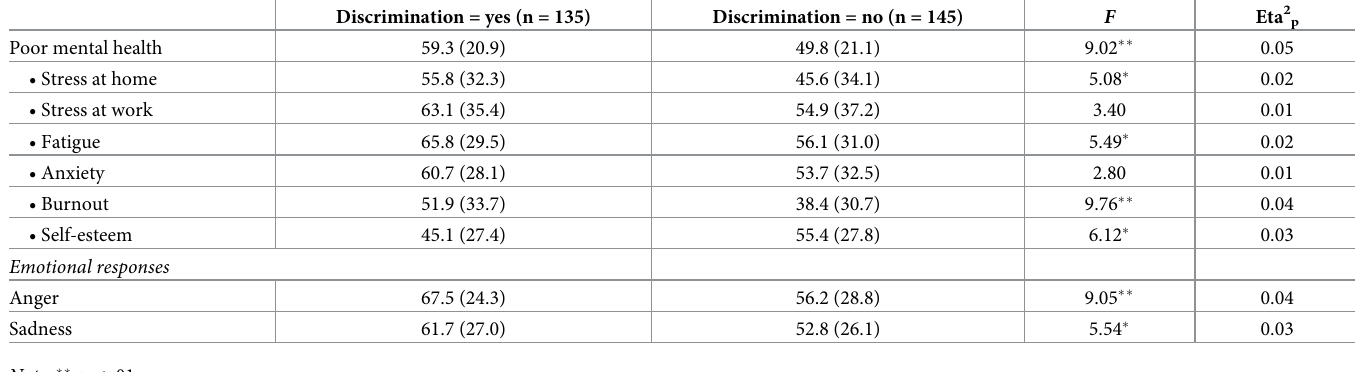
Table 3. Marginal mean estimates (and standard deviations) for both mental health and emotional responses, within both no- and discrimination groups, when depression medication is controlled for (analysis of